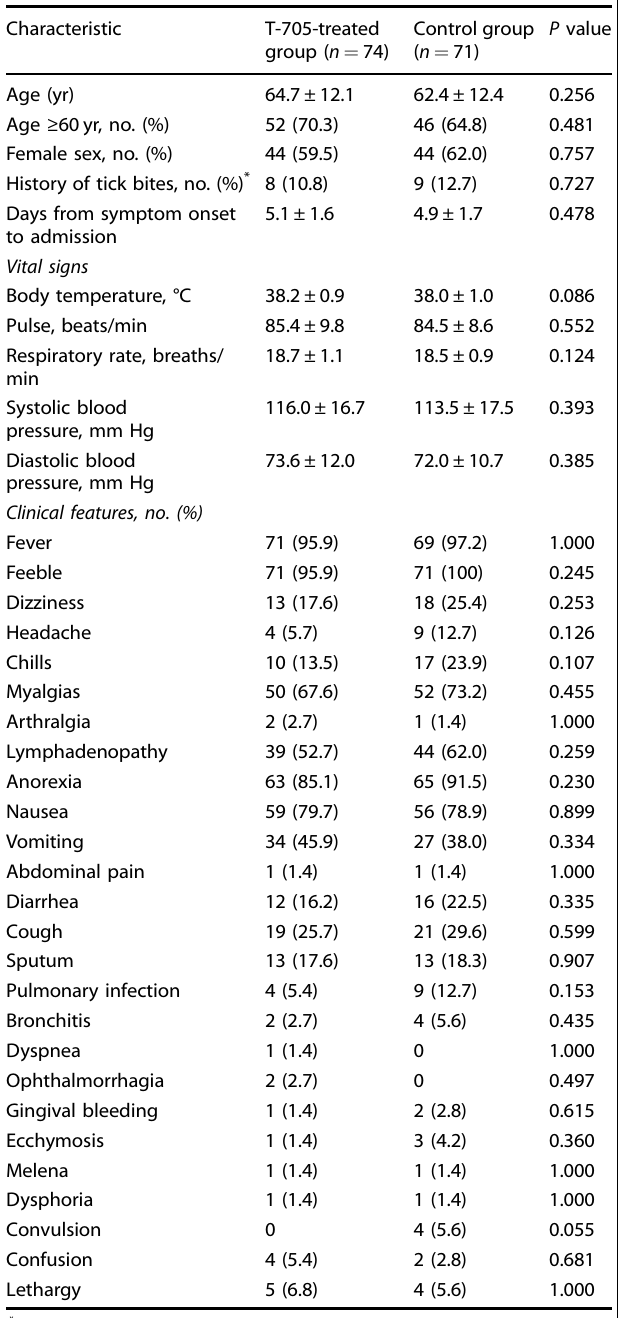
Table 1. Baseline demographic characteristics, vital signs, and clinical features of the SFTS